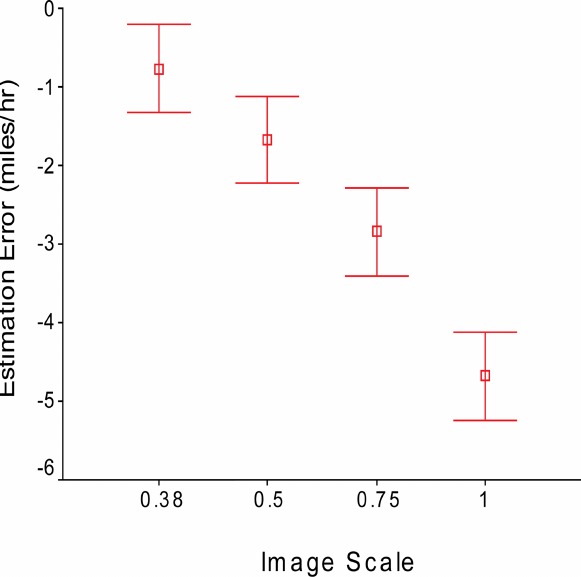
Fig 2. Underestimation of speed increaseswith increasing image